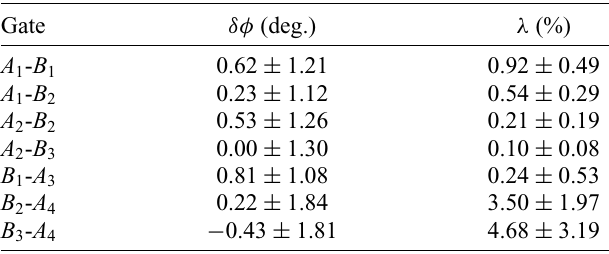
TABLE II. Average phase deviation from target, δφ , and aver- age leakage, λ , for the seven C Z φ gates used in the